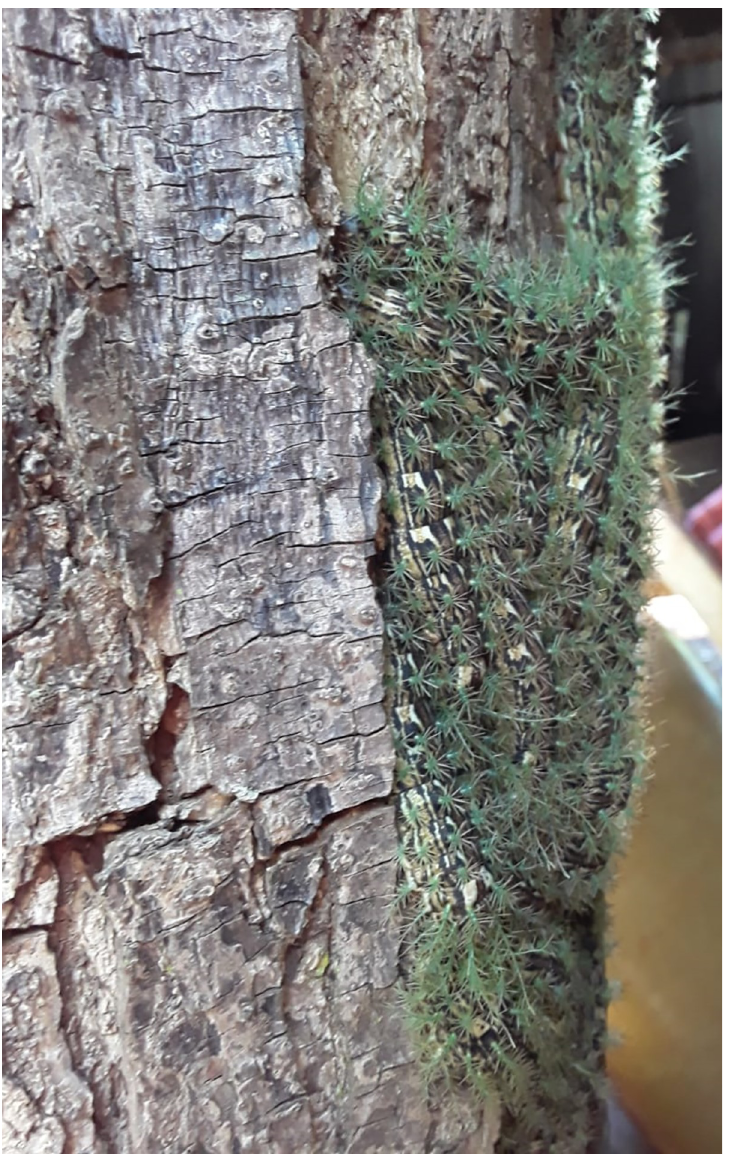
Fig 1. A colony of Lonomia sp. caterpillars on the trunk of a host